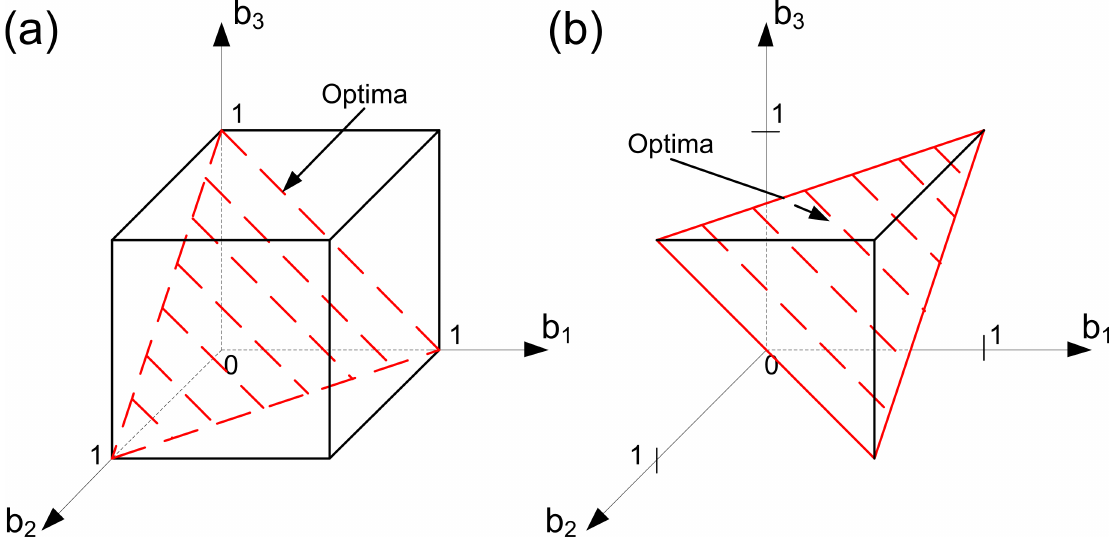
Fig 4. Evolution of germ and soma in colonies with identical cells: A linear trade-off, a resource constraint and different ‘importances’ of viability and fecundity. Here we assume that we have three groups of cells within the colony such that all cells from each group have the same level of fecundity and the same level of viability (i.e., we have three ‘aggregate’ cells in the colony). In panel (a), Case 1 is illustrated. In panel (b), Case 3 is illustrated. With a linear trade-off there is no Case 2 in the model (i.e., it means that the set of parameters that lead to Case 2 in the space of all possible parameters is a set of measure zero). Optimal strategies of the colony are colored in red. With a linear trade-off, identical colony behaves as a single cell. In all panels, α = 1, β = 2, k 1 = 1, C = 4 and φ = 1- b . In panel (a), k 2 = 1. In panel (b), k 2 =